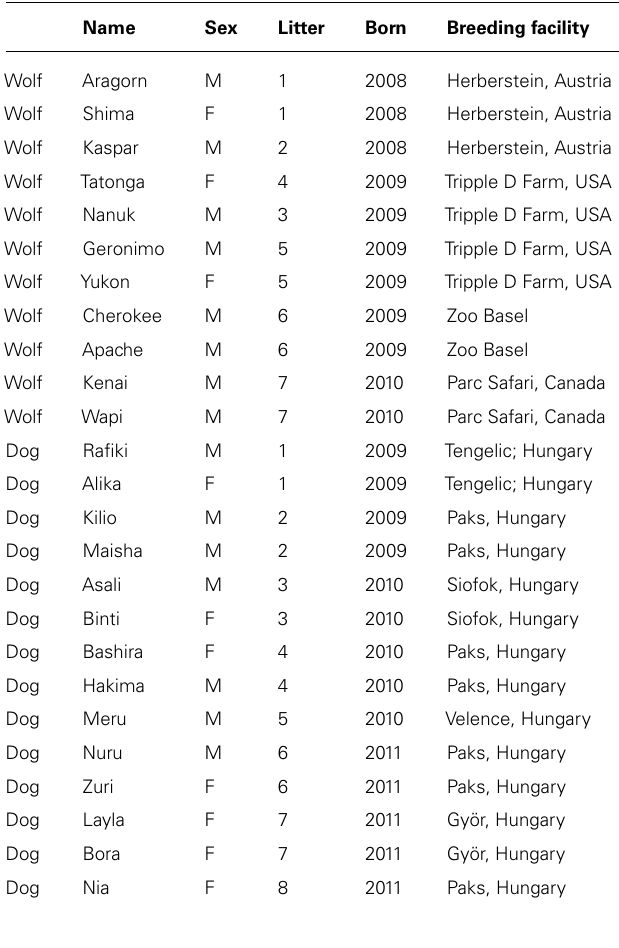
Table 1 | List of animals, indicating genetic relationships (litter), sex (male/female), age, and